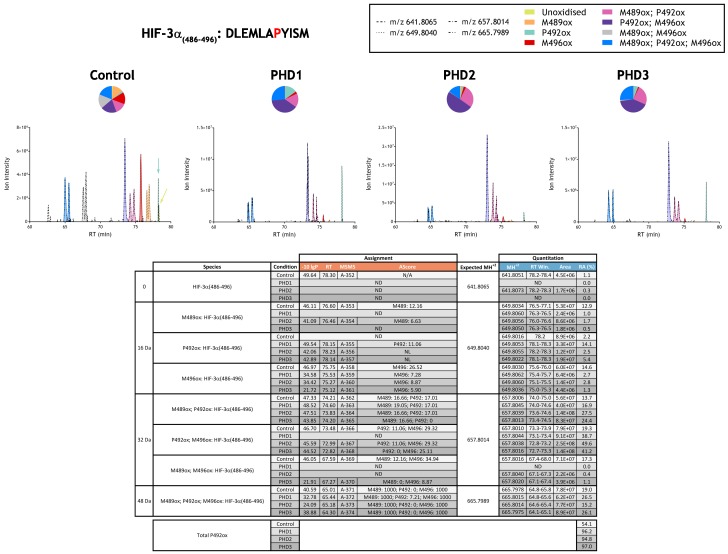
Quantitation of PHD-catalysed hydroxylation at the P492 site in hypoxia-inducible factor 3α.Full-length HIF-3α protein produced by IVTT was incubated in the absence (Control) or presence of the indicated (PHD) enzyme and digested with Asp-N. Relative quantitation of P492ox is presented as XIC of m/z 641.8065, 649.8040, 657.8014 and 665.7989 corresponding to unoxidised and multiply oxidised forms of the HIF-3α(486-496) peptide bearing two readily oxidised Met residues (M489 and M496). Species lacking supportive MSMS were assigned by exact mass and retention time similarity. MSMS assigned species are coloured (see inset). Note, the relative increase in P492ox containing species [(P492ox, turquoise), (M489ox; P492ox, pink), (P492ox; M496ox, purple), (M489ox; P492ox; M496ox, blue)] upon incubation with recombinant PHD enzyme. Quantitative data for observed species are presented as pie charts above chromatograms. Assignment and quantitation data are tabulated below with the following headers: (−10lgP) significance score of leading assignment at given (RT) with ambiguity score (AScore) for PTM localisation and reference to primary MSMS data in Supplementary file 1. Quantitative data reports ion counts (Area) of observed masses (MH+2) integrated over time (RT Win.), expressed as relative abundance (RA). Total P492ox is an aggregated ratio of prolyl to hydroxyprolyl containing ions.